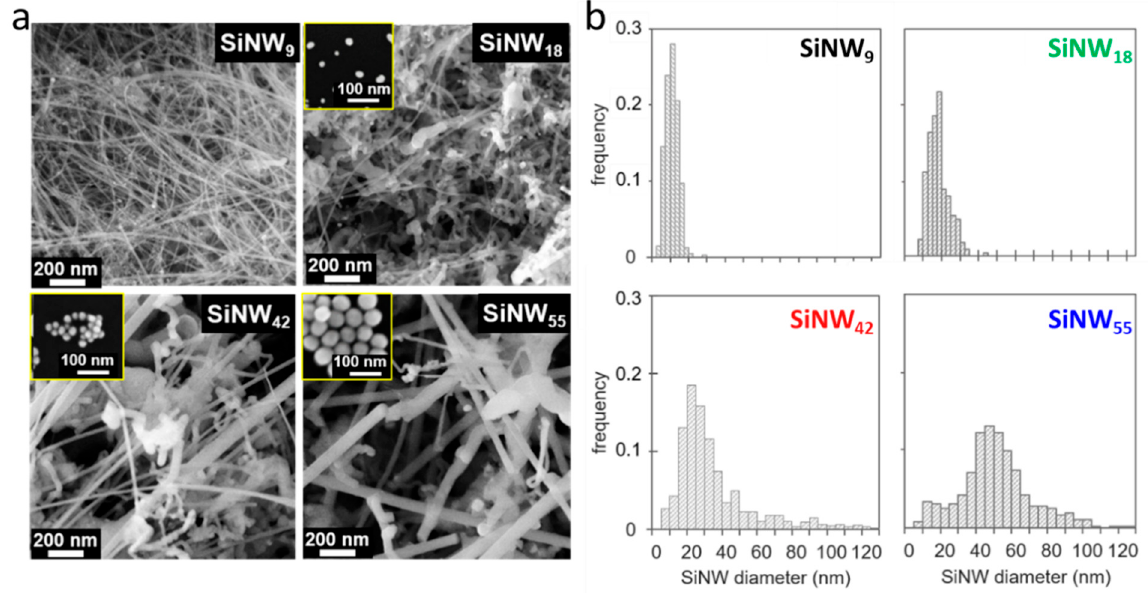
Figure 3. SEM images ( a ) and corresponding diameter histograms ( b ) of SiNWs. Insets: SEM images of the AuNP catalysts used for each SiNW growth. Histograms are calculated on >250 counts.